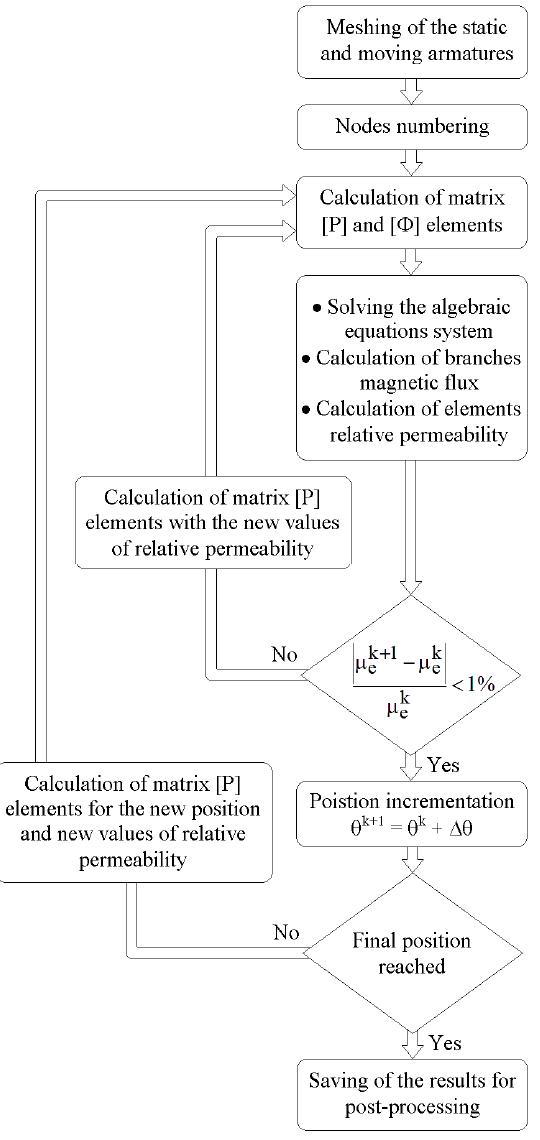
Figure 20. Mesh-based generated MEC method algorithm.